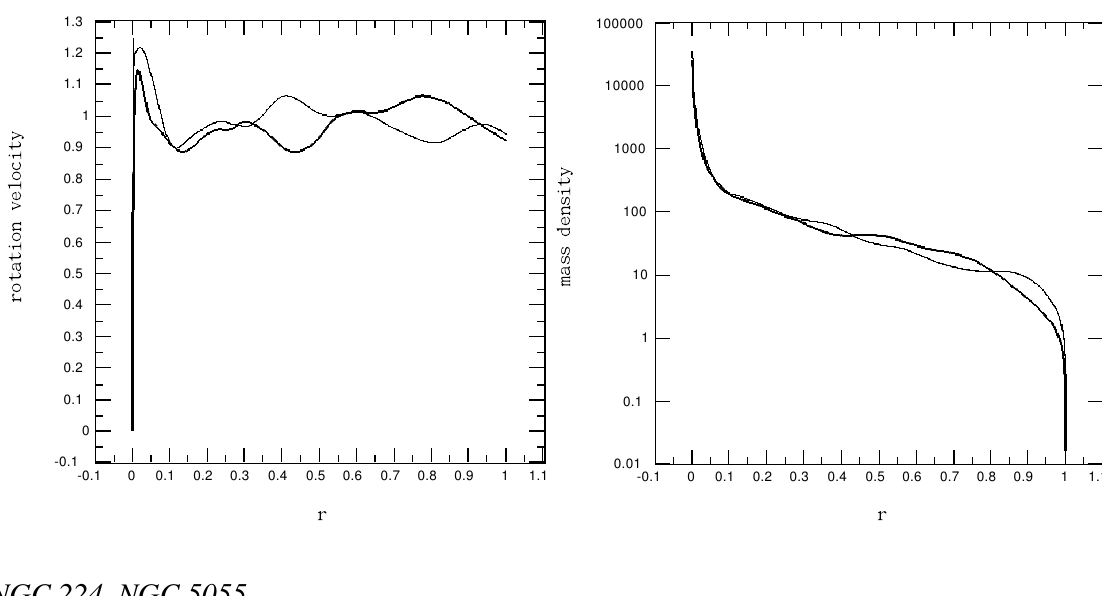
Figure 3. Profiles of the Milky Way and NGC 4945 rotation velocity V ( r ) and mass density ρ ( r ) , with the thick line for that of the Milky Way and the thin line for NGC 4945 . The computed values of the galactic rotation number, A , are 1 . 6365 and 1 . 6873 for the Milky Way and NGC 4945 ,